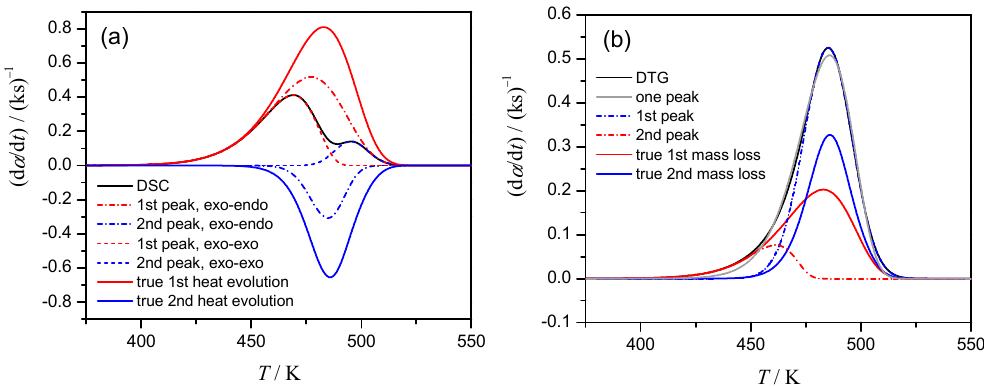
Figure 3. Selection of the peak combinations for Case 1, β = 1 K min − 1 : ( a ) superposition of two exothermic processes (dotted lines) or exothermic and endothermic ones (dashed lines) results in perfect correlation with DSC signal (black solid) but completely different from true heat evolution data, ( b ) DTG peaks are described well both by two peaks (dashed lines) and by single peak (dotted line), but both are different from true signals.